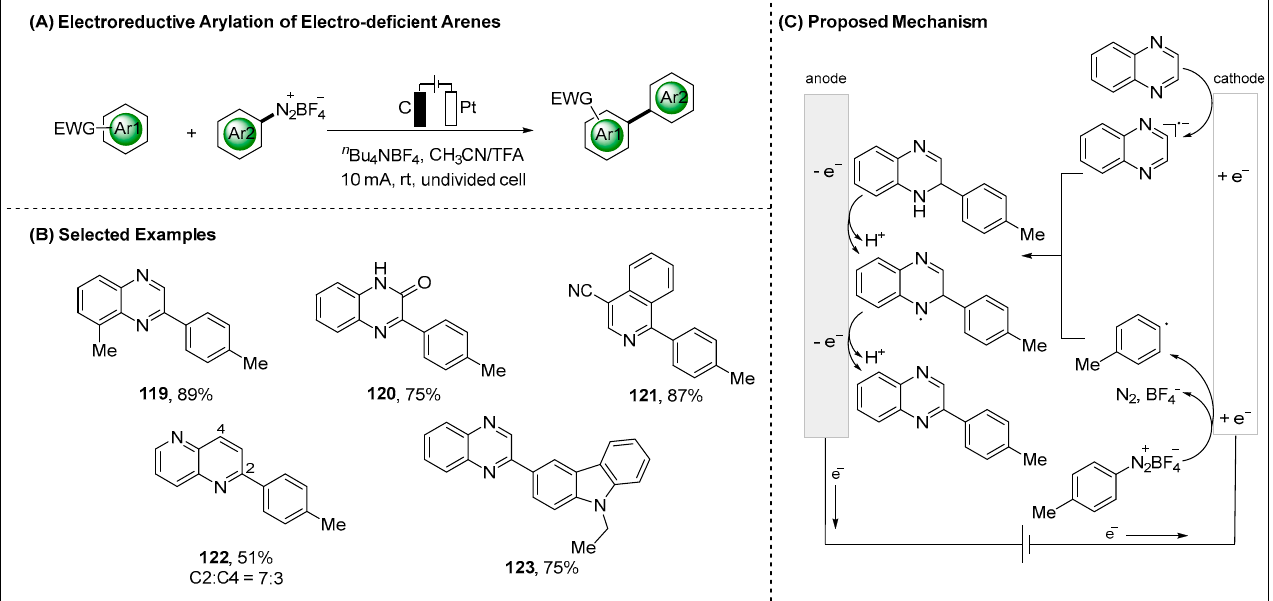
Figure 14. Direct electroreductive hydrodehalogenation and deuterodehalogenation of aryl hal- ides.